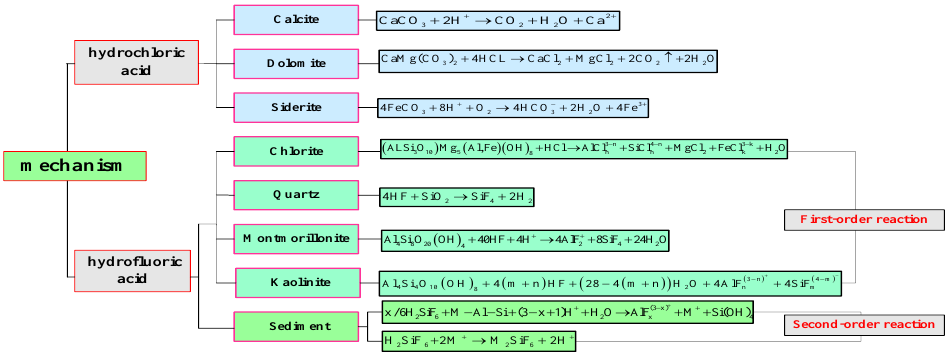
Figure 2. Reaction mechanism of minerals and acids.